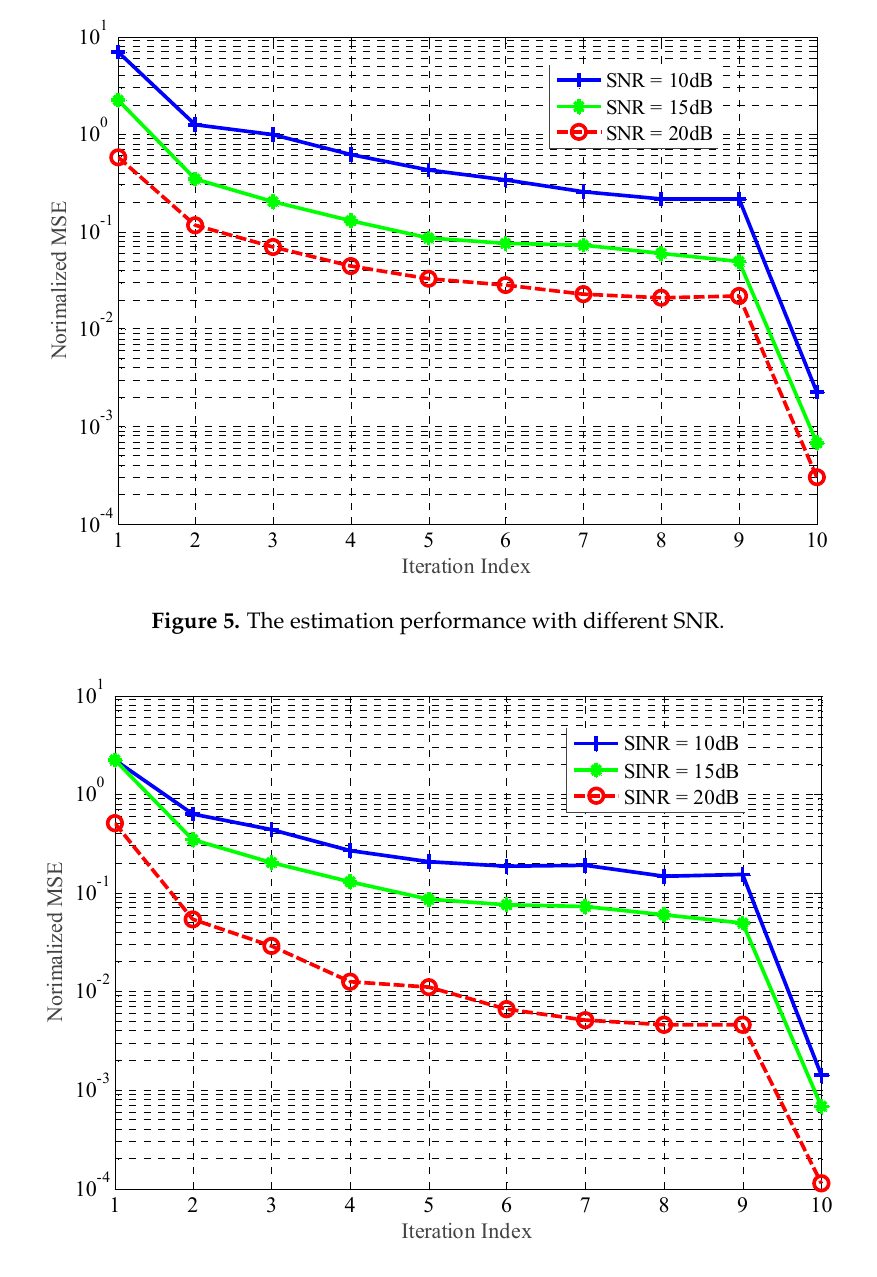
Figure 6. The estimation performance with different SINR.